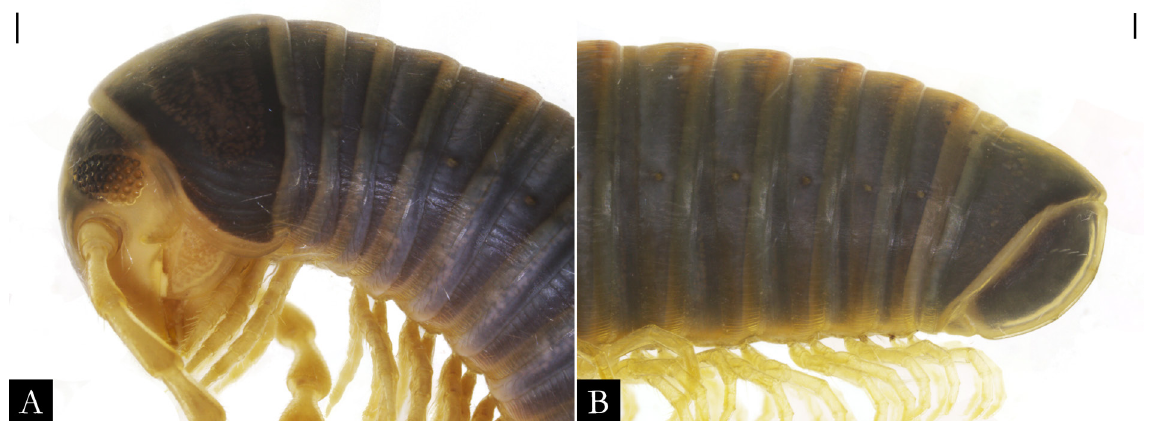
Fig. 157. Pseudonannolene morettii sp. nov., ♀ (IBSP 2471), in lateral view. A . Anterior region. B . Posterior region. Scale bars = 0.2